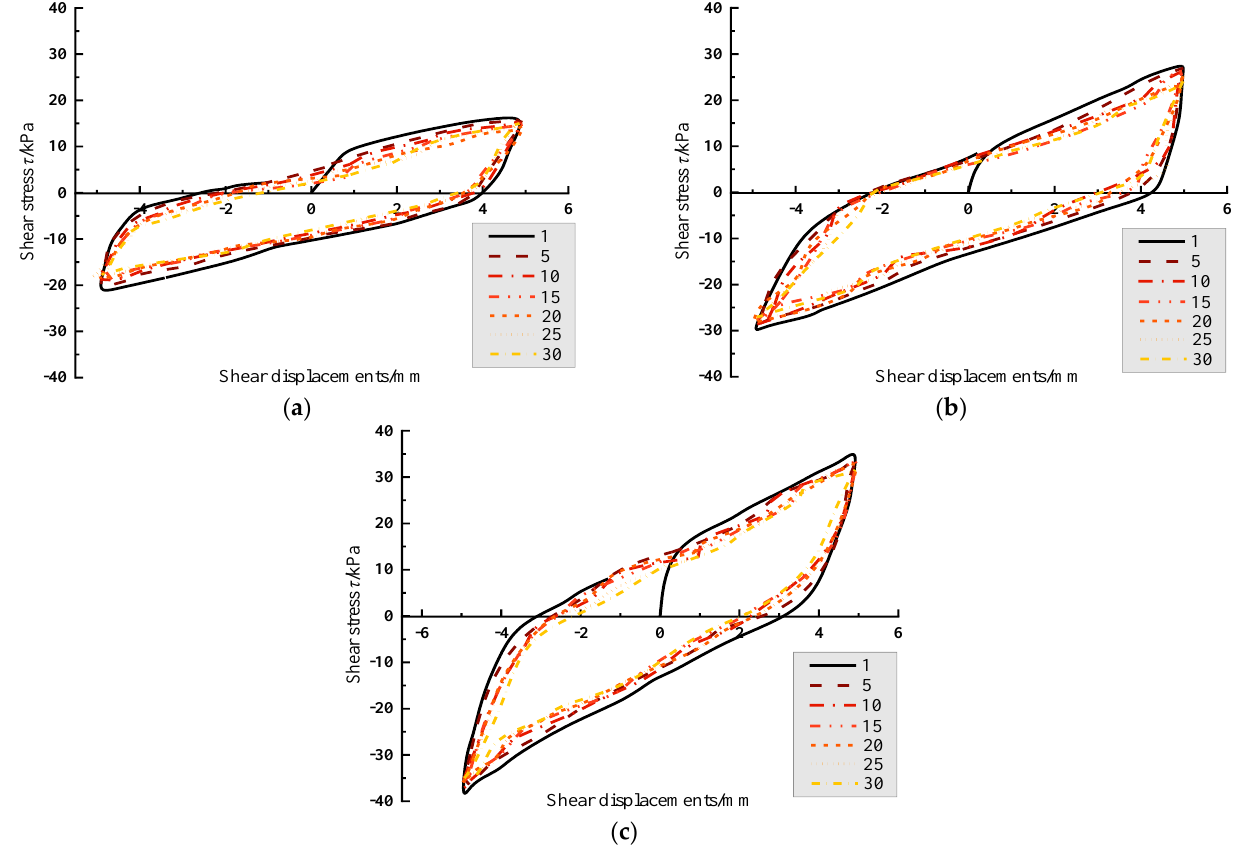
Figure 5. Shear stress-shear displacement curves under different constant normal stresses: ( a ) 100 kP a ; ( b ) 200 kP a ; ( c ) 300 kP a .